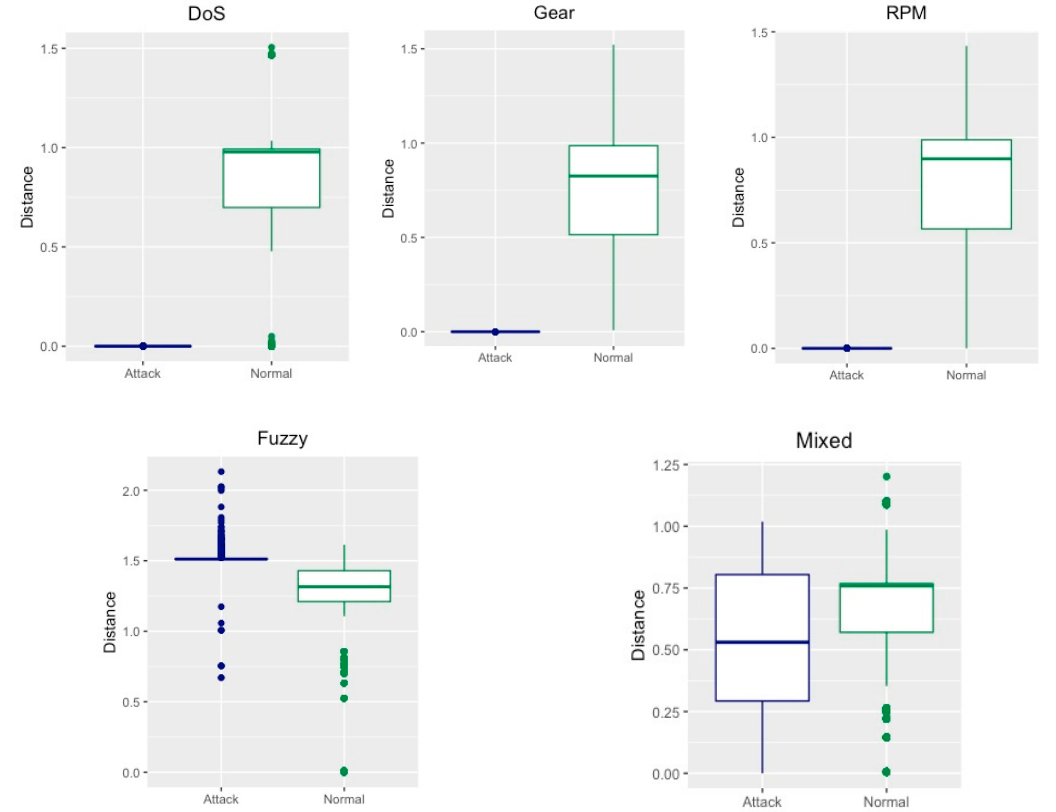
Figure 9. Distances between the input vectors and the winning neurons for the XYF network on the 4 × 4 neurons map.